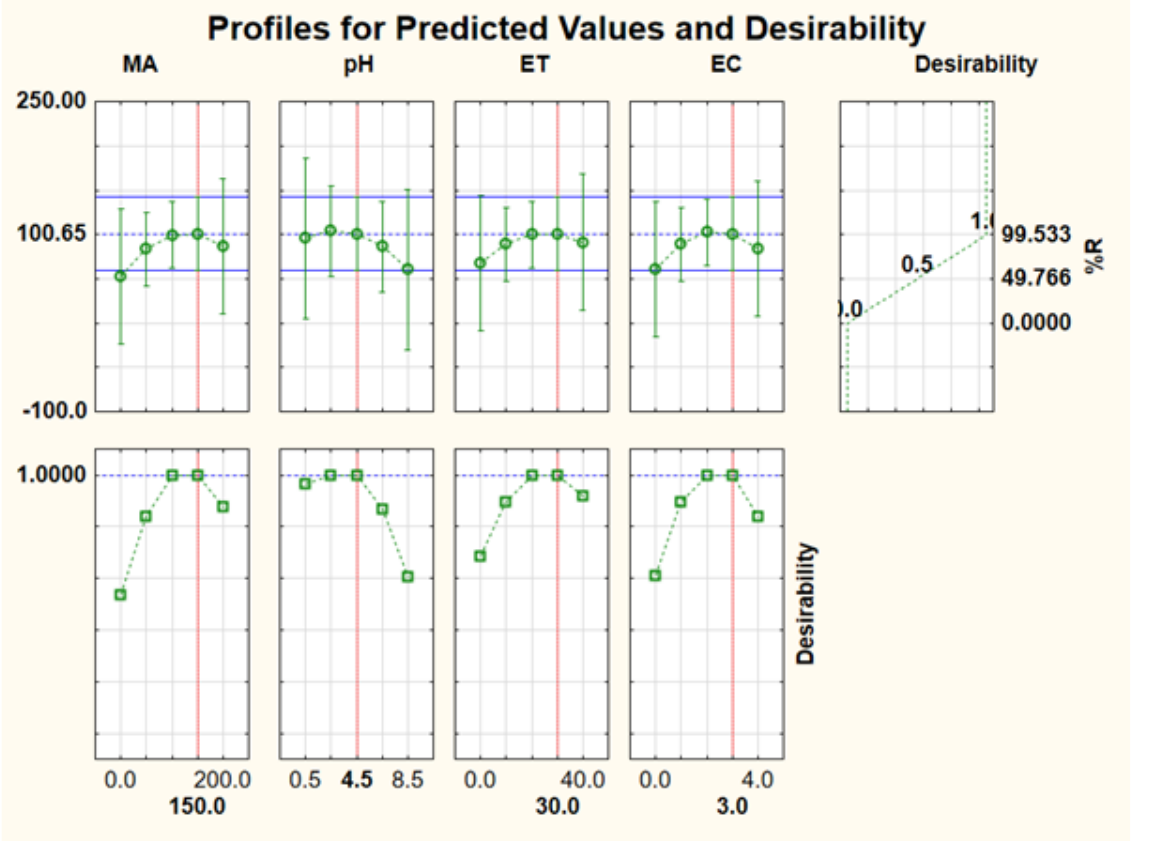
Figure 11. Profile of predicted values and desirability for optimisation of experimental parameters affect the extraction and recovery of Au(III) and Pd(II).